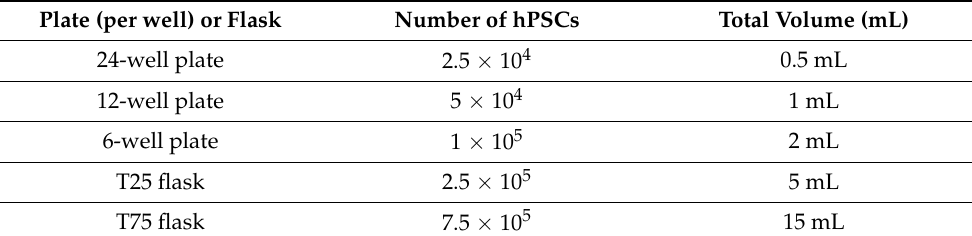
Table 4. Number of hPSCs to be seeded per plate or